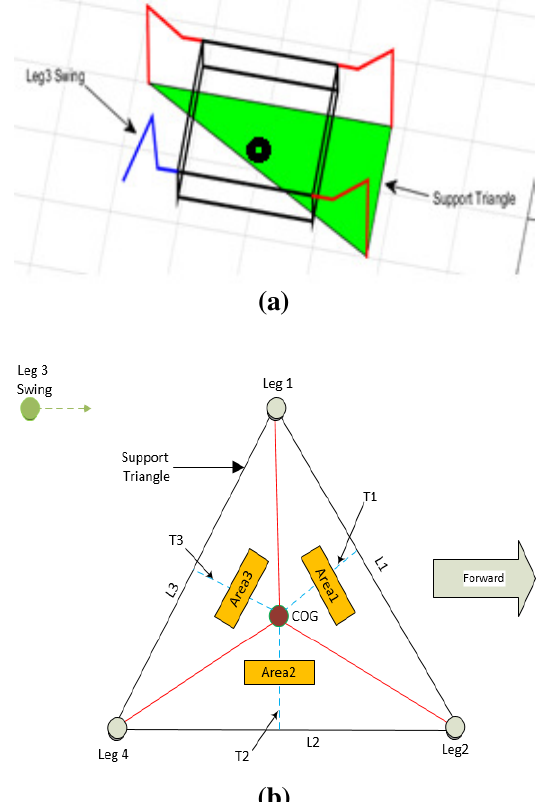
Fig. 10. Quadruped robot when leg3 is swinging (a) quadruped robot 3D view (b) Quadruped support